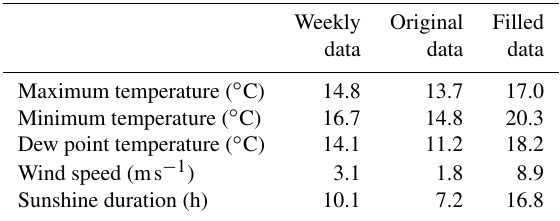
Table 3. Percentage of data affected by